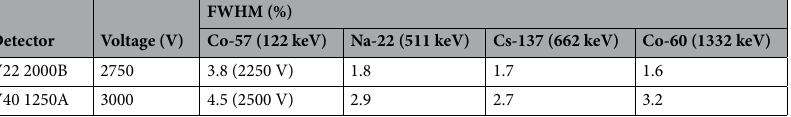
Table 4. FWHM of spectra from the reported sources acquired with the most performant detector of type V22 and V40. The voltages in brackets are referred to measures with a bias different from the one in the corresponding row. Measurements were carried out at 20